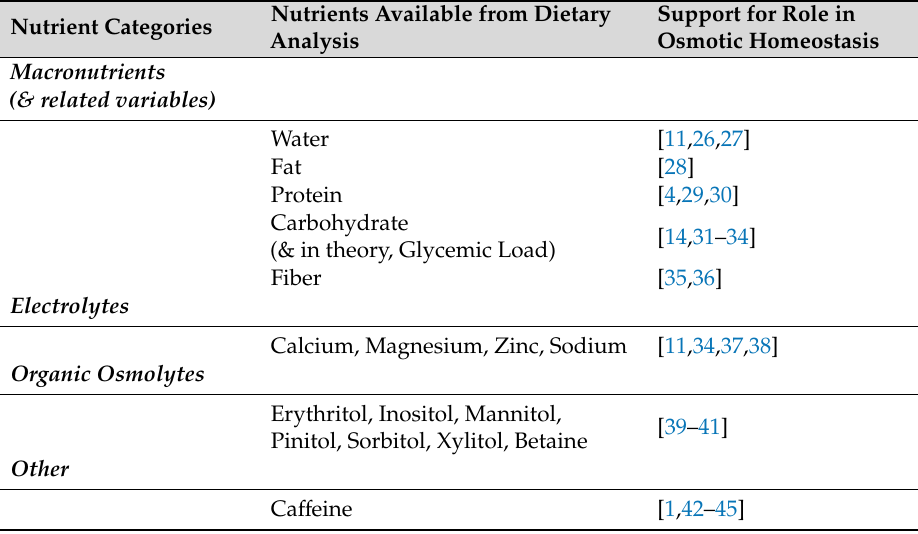
Table 1. Dietary nutrients related to osmotic